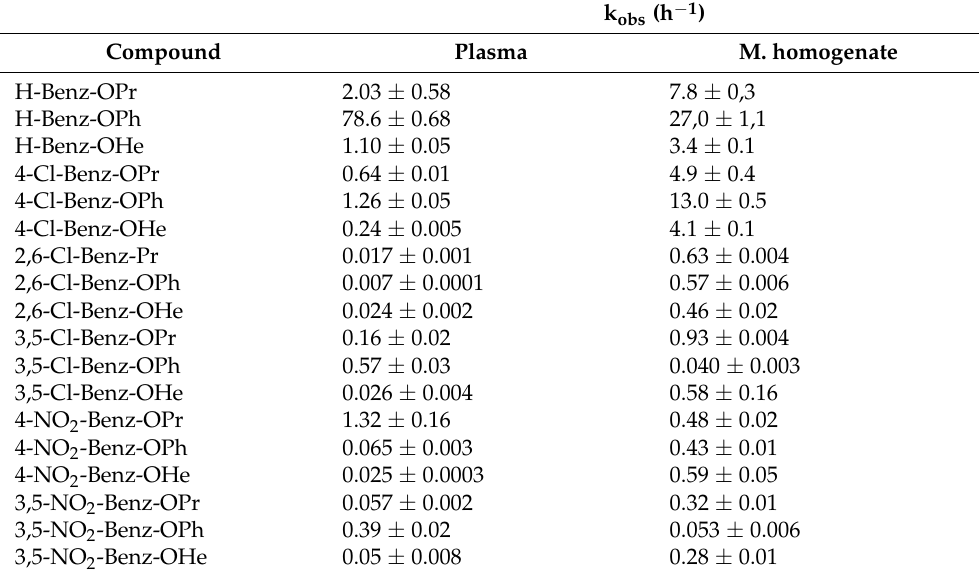
Table 2. Pseudo first order rate constants for the hydrolysis of the benzoates in 80% human plasma and in mycobacterial homogenate. Data are representative of three independent experiments and values are expressed in mean ± SD.